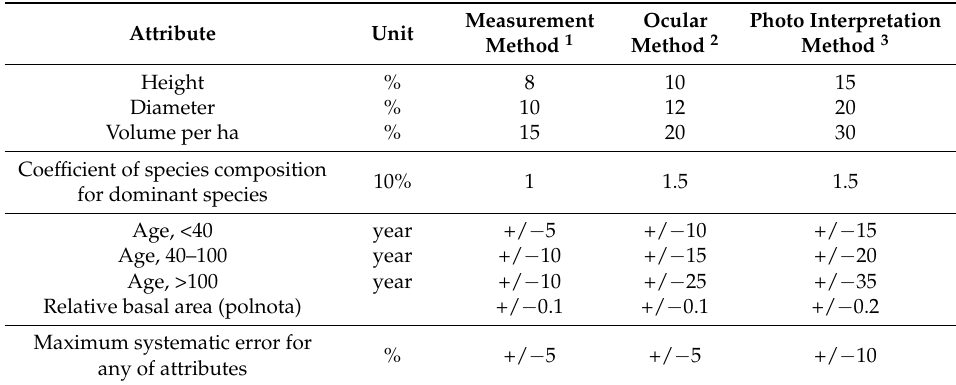
Table 7. Stand-level accuracy requirements of main forest parameters for different forest inventory methods in Russia. Attribute Unit